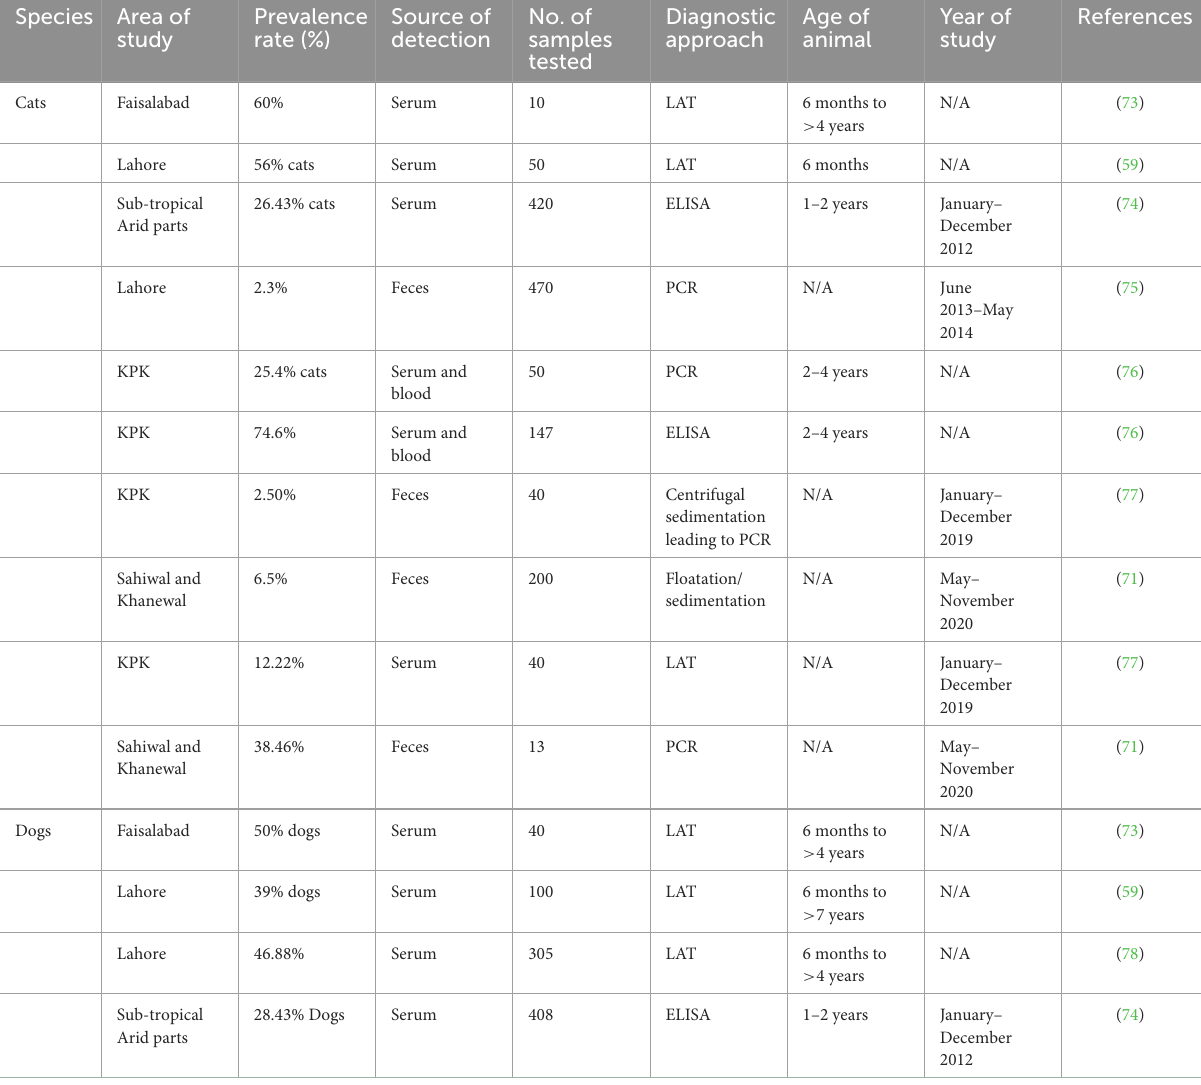
TABLE 2 Reported prevalence of Toxoplasma gondii in cats and dogs in Pakistan. Species Area of